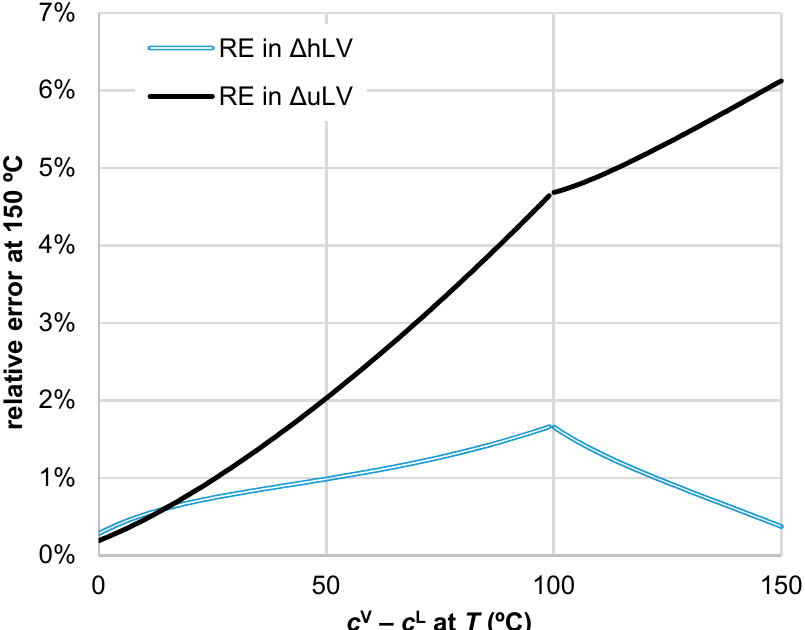
Figure 8. Relative error in Δ h LV and Δ u LV at 150 °C using specific heat capacity pairs from reference values [13] at temperatures 0–150 °C.